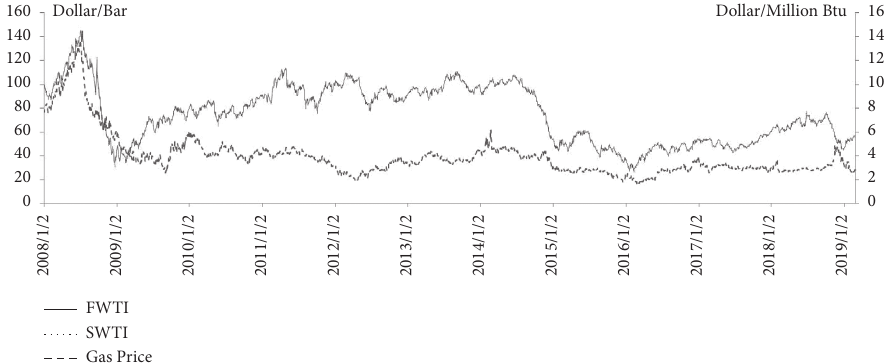
Figure 4: Relation between crude oil future prices, spot prices, and natural gas prices.